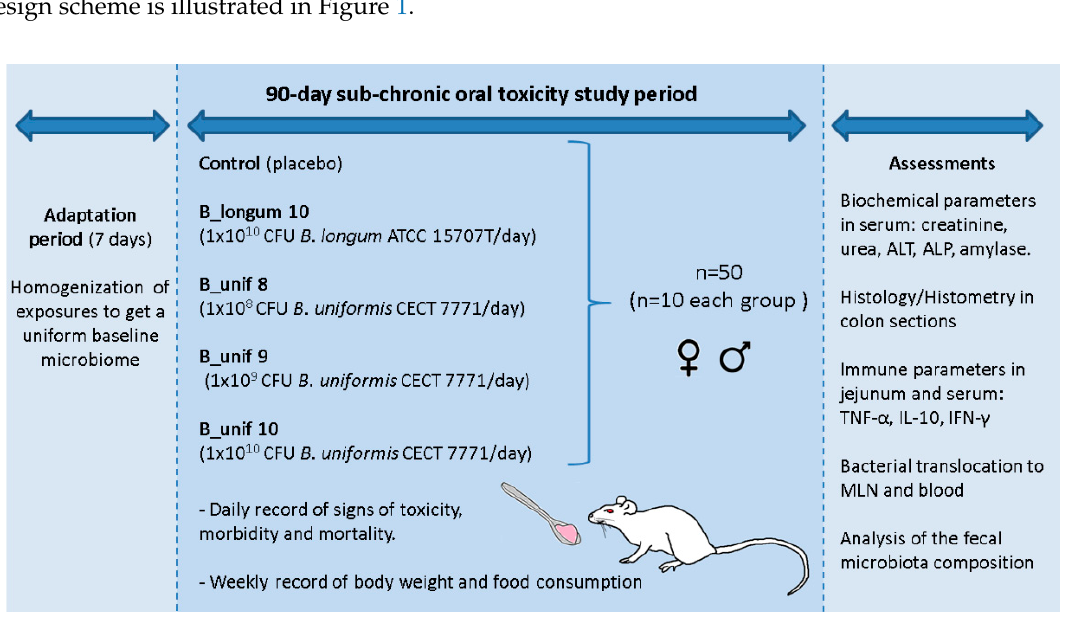
Figure 1. Schematic representation of the study protocol to evaluate the safety of Bacteroides uniformis CECT 7771 in a sub-chronic (90-day) oral toxicity study in rats. B_Unif, B. uniformis ; MLN, mesenteric lymph node. ALT: alanine aminotransferase, ALP: alkaline phosphatase, TNF- α : tumor necrosis factor-alpha, IL-10: interleukine-10, IFN- γ : interferon-gamma, ♀ : rat females, ♂ : rat males.